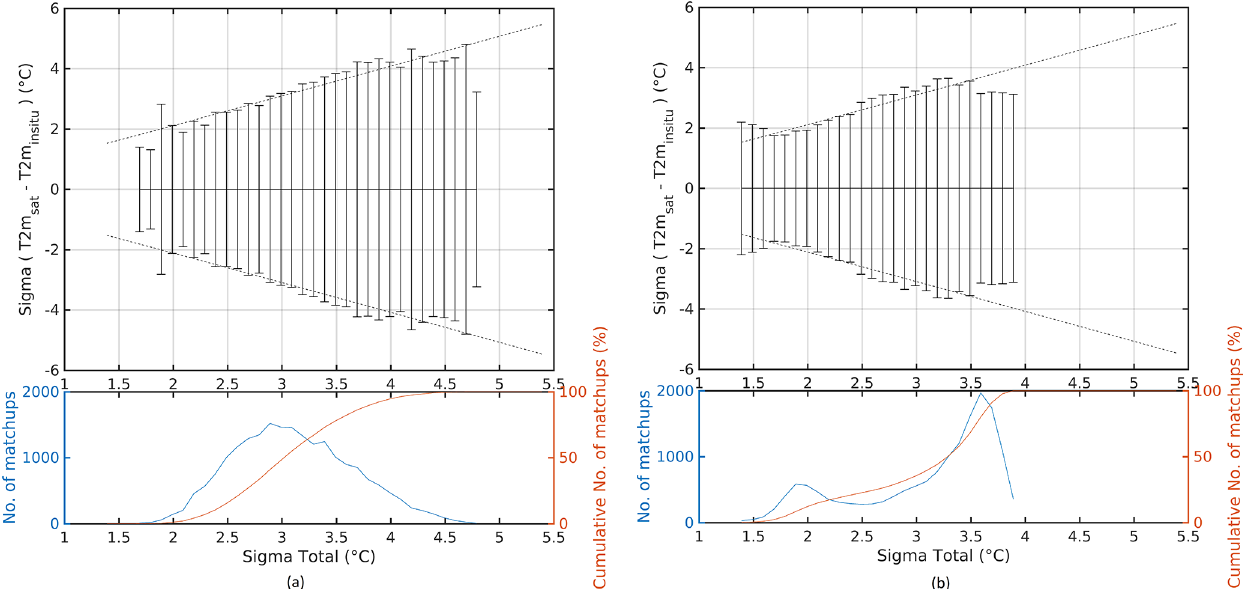
Figure 11. Satellite-estimated T2m uncertainty validation with respect to independent in situ T2m for (a) land ice and (b) sea ice. Dashed lines show the modelled uncertainty accounting for uncertainties in the in situ T2m and the sampling error. Solid black lines show 1 standard deviation of the estimated minus in situ differences for each 0.1 ◦ C bin. The bottom plots show the number of matchups (blue) and the cumulative percentage of matchups for each bin (red).